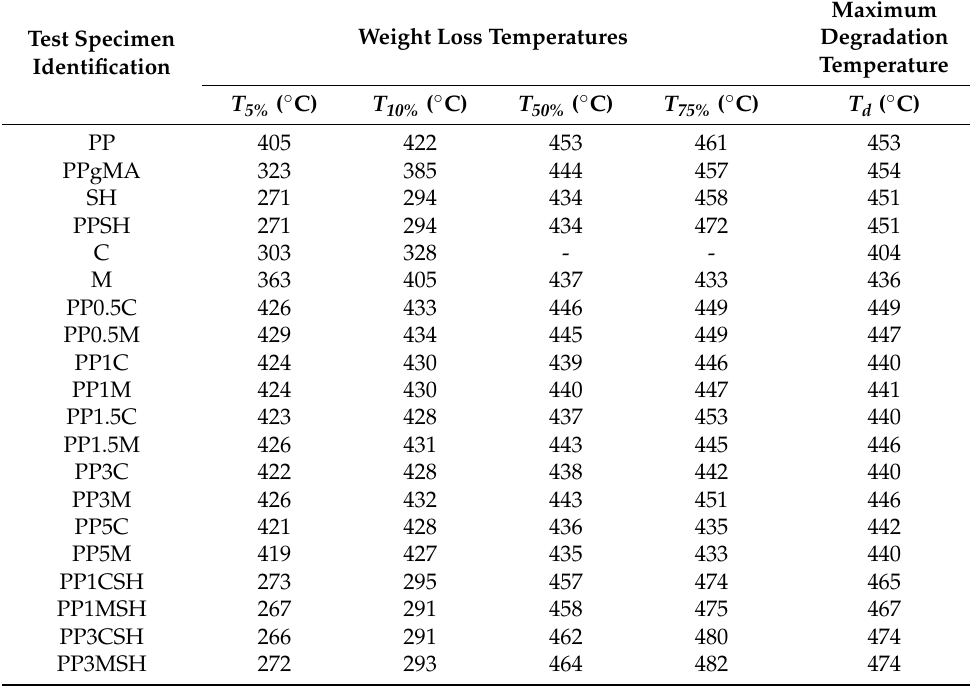
Table 3. Thermogravimetric properties of the investigated PP and PP